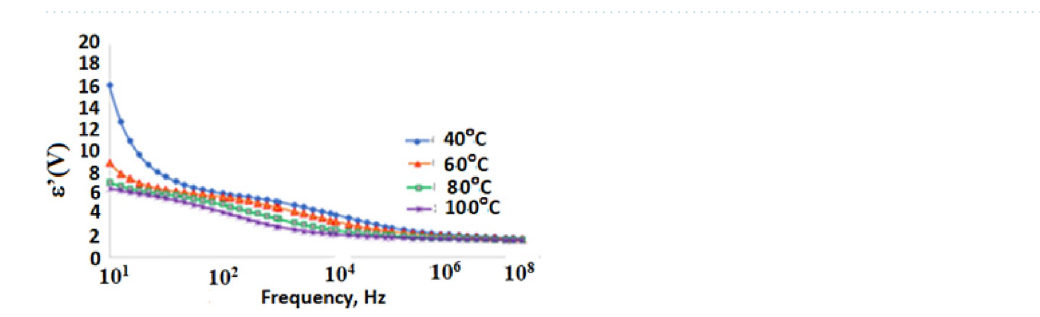
Figure 6. ( a ) TG-DTG and ( b ) DSC thermograms of the substituted polymer 2.